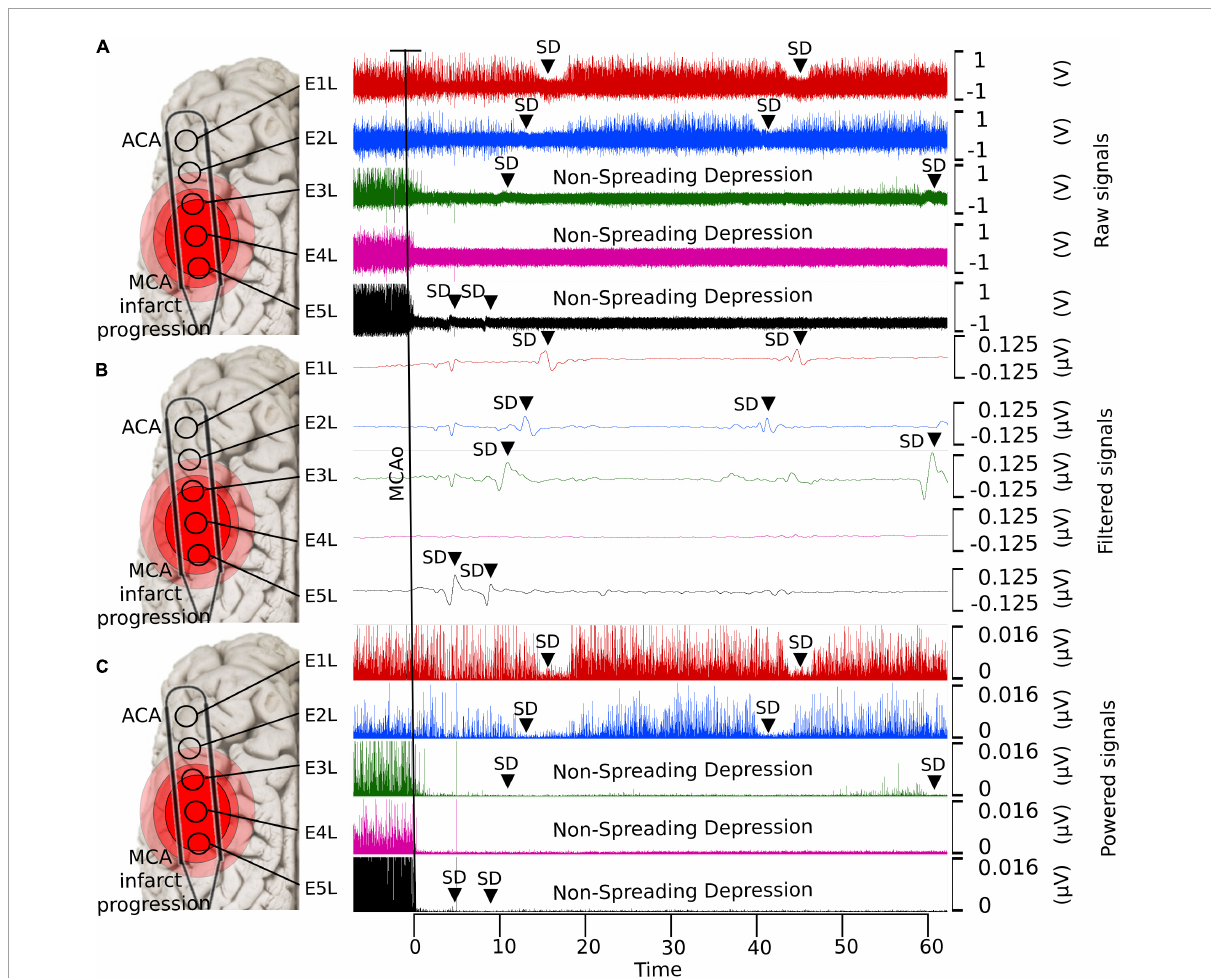
FIGURE1 Detection of SDs using ECoG with different filters. (A) Raw data, (B) low-pass filtered, and (C) powered signal. With the low-pass filter, it is possible to observe the shape of the near-DC shift typic of the SDs. The non-spreading depression occurring after the MCAo is highlighted in the last two electrodes (E4L-E5L) at the raw and powered signal filters, which correspond to the site close to the MCAo. SD, spreading depolarization; ECoG, electrocorticography; DC, direct current; MCAo, middle cerebral artery occlusion.